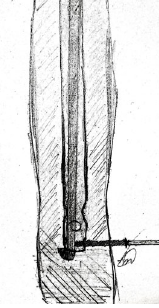
Figure 9. Modified AO technique using a cortical screw to deflect the hook.